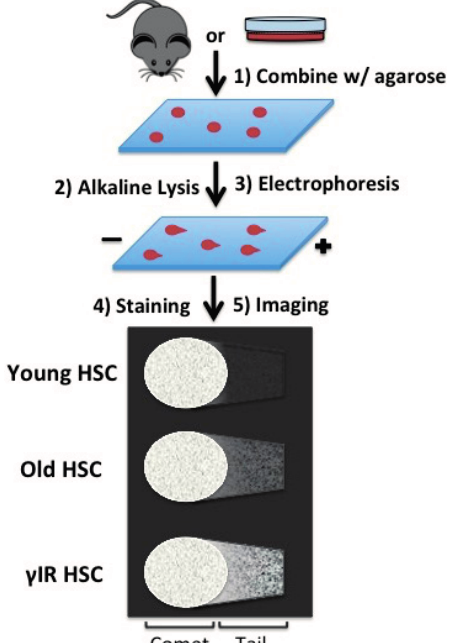
Figure 2. The alkaline comet assay. The alkaline comet assay allows for the direct microscopic measurement of DNA damage. Isolated cells are mixed with low-temperature gelling agarose and applied to a glass slide. Cells are lysed under alkaline conditions in order to detect single and double strand breaks, though a number of lysis procedures have been described for other purposes. After a brief electrophoresis and staining, DNA damage can be visualized microscopically. High molecular weight DNA, reflecting undamaged DNA, remains in the comet, whereas damaged DNA is susceptible to the electrophoretic field and is found in the tail. A number of methods for quantifying and describing the tail to comet relationship have been described. In Beerman, et al. the authors describe a higher frequency of HSCs with moderate-to-severe DNA damage in aged mice as compared to younger mice [28]. Damage is also more severe among aged hematopoietic stem cells as compared to aged hematopoietic